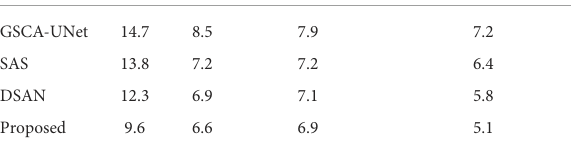
TABLE 3 The average detection results on the remote sensing dataset. Method